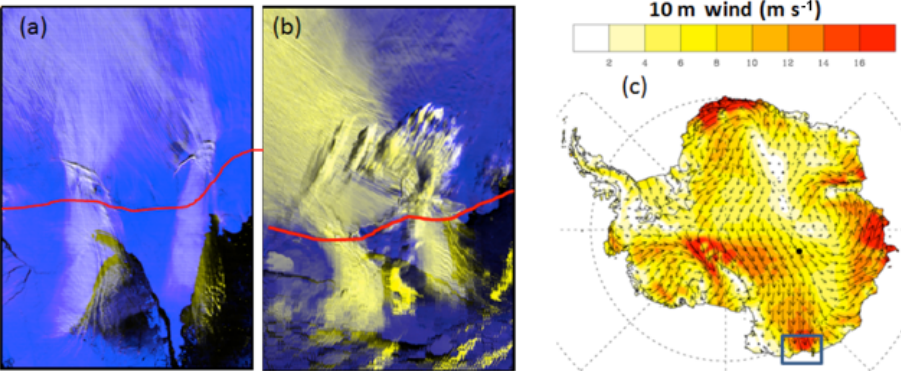
Figure 7. (a) MODIS false-color image on 13 October 2009, 23:00UTC, and (b) 14 October 2009, 06:16UTC. The red line is the approxi- mate position of the coastline. (c) The 10m wind speed from the AMPS model (Antarctic Mesoscale Prediction System) for 14 October 2009. The area covered by the MODIS images is roughly that indicated by the blue box in panel (c) . Table 2. The total transport (Gtyr − 1 ) from continent to ocean for various regions in Antarctica for 2007–2015. Year East Antarctica West Antarctica 135–160 ◦ E 80–120 ◦ W